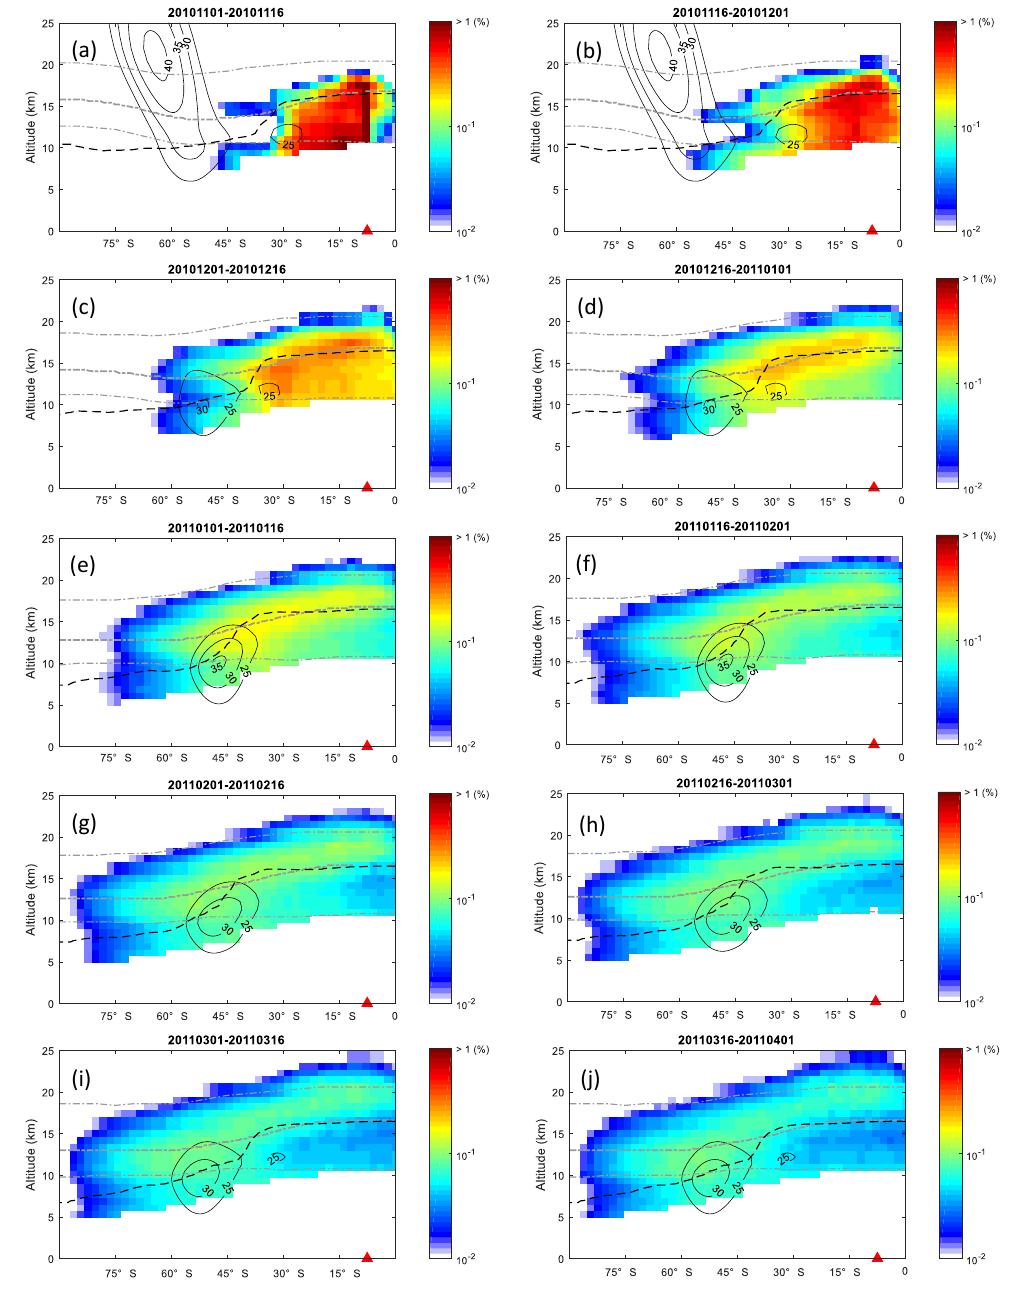
Figure 4. Percentage (%) of air parcels in proportion to the total number of air parcels released in the Lagrangian forward simulation, overlaid with monthly mean zonal winds (black contours), the thermal tropopause (black dashed line), the 380K potential temperature isoline (thick gray dashed line) and 350 and 480K potential temperature isolines (thin gray dashed lines). Results are binned every 2 ◦ in latitude and 1km in altitude. The red triangle denotes the latitude of Mount Merapi. Please see title of each panel for the time period